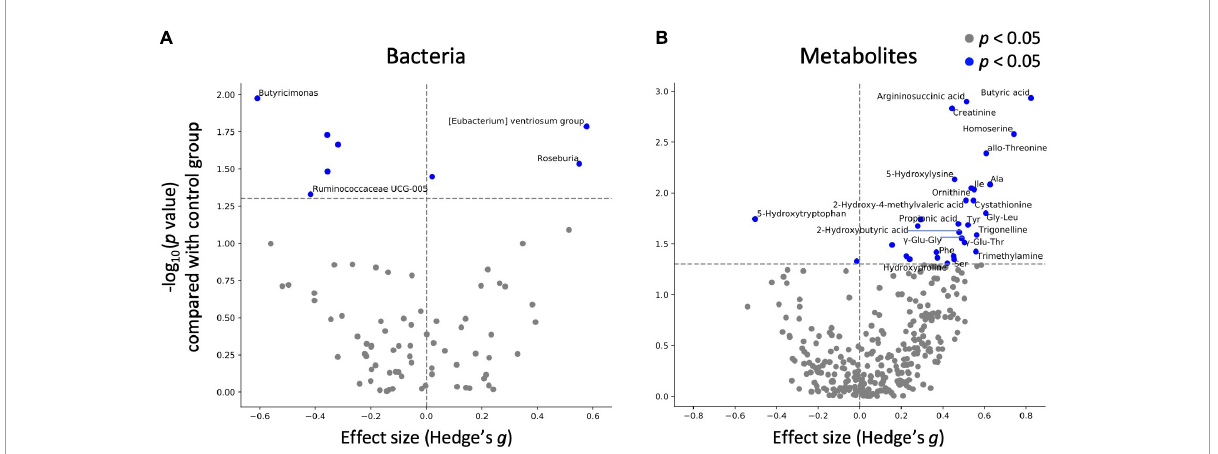
FIGURE3 Effect of mushroom intake on gut microbes and metabolites. The x -axis represents the effect size (Hedges’ g) of mushroom intake compared with the control group. The y -axis represents the logarithm of the Wilcoxon signed-rank test p -value compared with the control group. If absolute value of x -axis is larger than 0.4 and p < 0.05 in y -axis, (A) bacterium or (B) metabolite names were labeled.